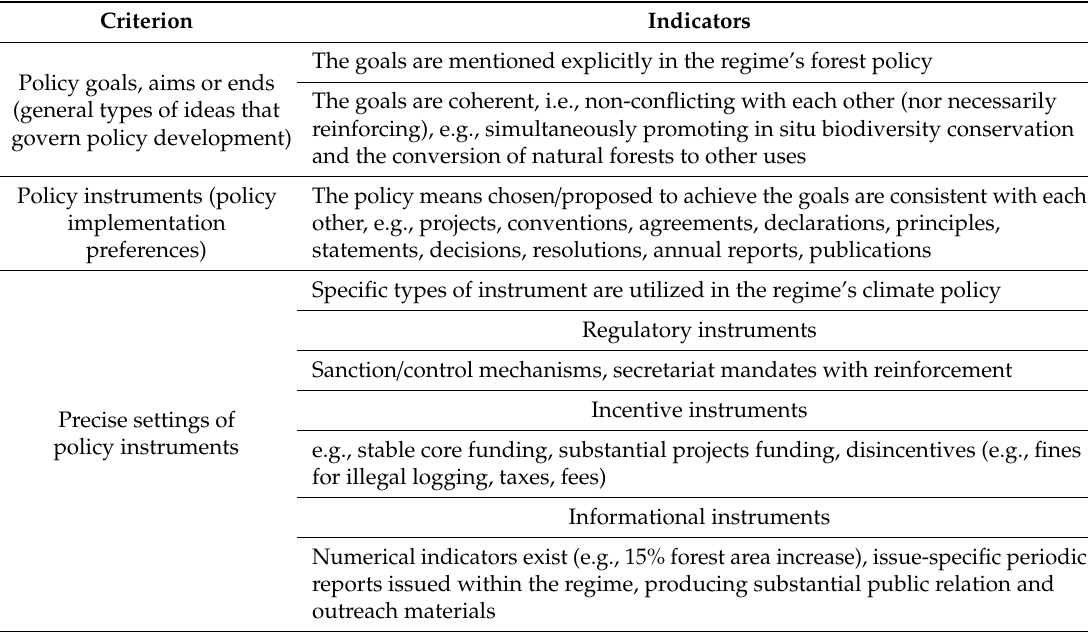
Table 2. Measurable criteria and indicators of policy components adapted from